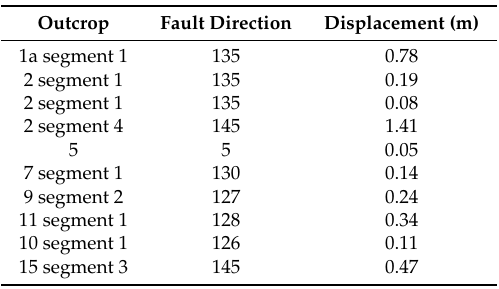
Figure 17. ( A ) Fault displacement in the outcrop 17 segment 3; ( B ) displacement in outcrop 26 segment 1; ( C ) Fault displacement in outcrop 56. Table 3. Fault evidence and their displacement in study